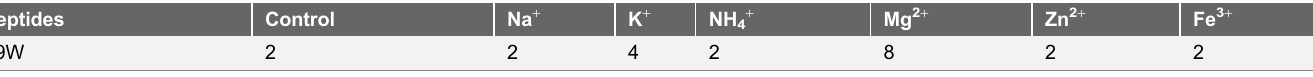
a The values represent the MICs of T9W in the absence or presence of salts, and the concentrations of the salts were as follows: 150 mM NaCl, 4.5 mM KCl, 6 m M